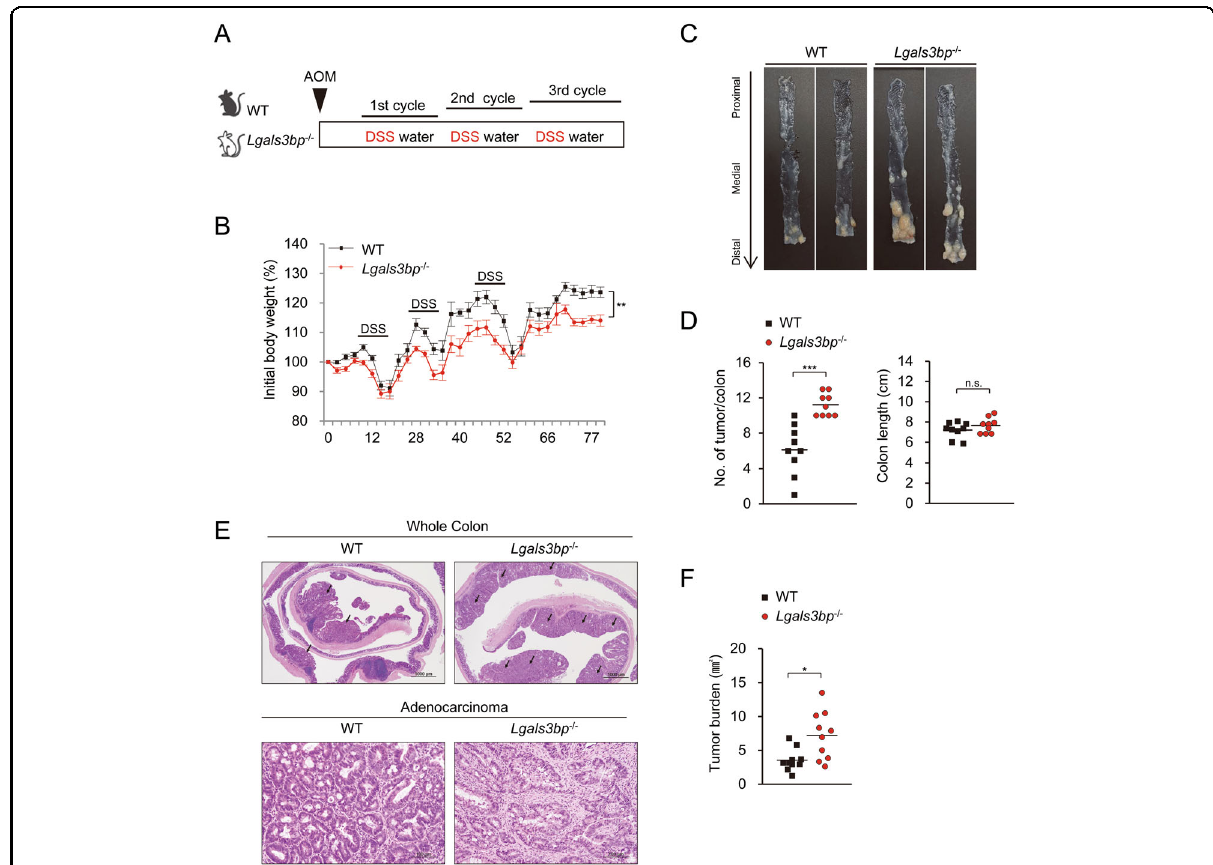
Fig. 5 Hyper-susceptibility of Lgals3bp − / − mice to colon tumorigenesis. A Schematic overview of the AOM/DSS protocol of colon tumorigenesis model. In brief, WT ( n = 9) and Lgals3bp − / − ( n = 9) mice were treated intraperitoneally with AOM (10 mg/kg). After 5 days, mice were treated with 2.5% DSS in drinking water for 1 week. Thereafter, mice were fed with regular water for 2 weeks and subjected to two more DSS administration cycles. Mice were sacri fi ced at day 95 following AOM injection. B Body weight was monitored during AOM/DSS-induced tumorigenesis. C Representative image of tumor-bearing colons from WT and Lgals3bp − / − mice. D The tumor number per colon was counted and colon length was measured. E Upper: Representative picture of H&E stained tumor-bearing colons. Arrows indicate tumor lesions. Lower: Representative adenocarcinoma in the colon F Tumor burden was measured based on histological analysis. The solid line within the graph represents the mean value. ** p <